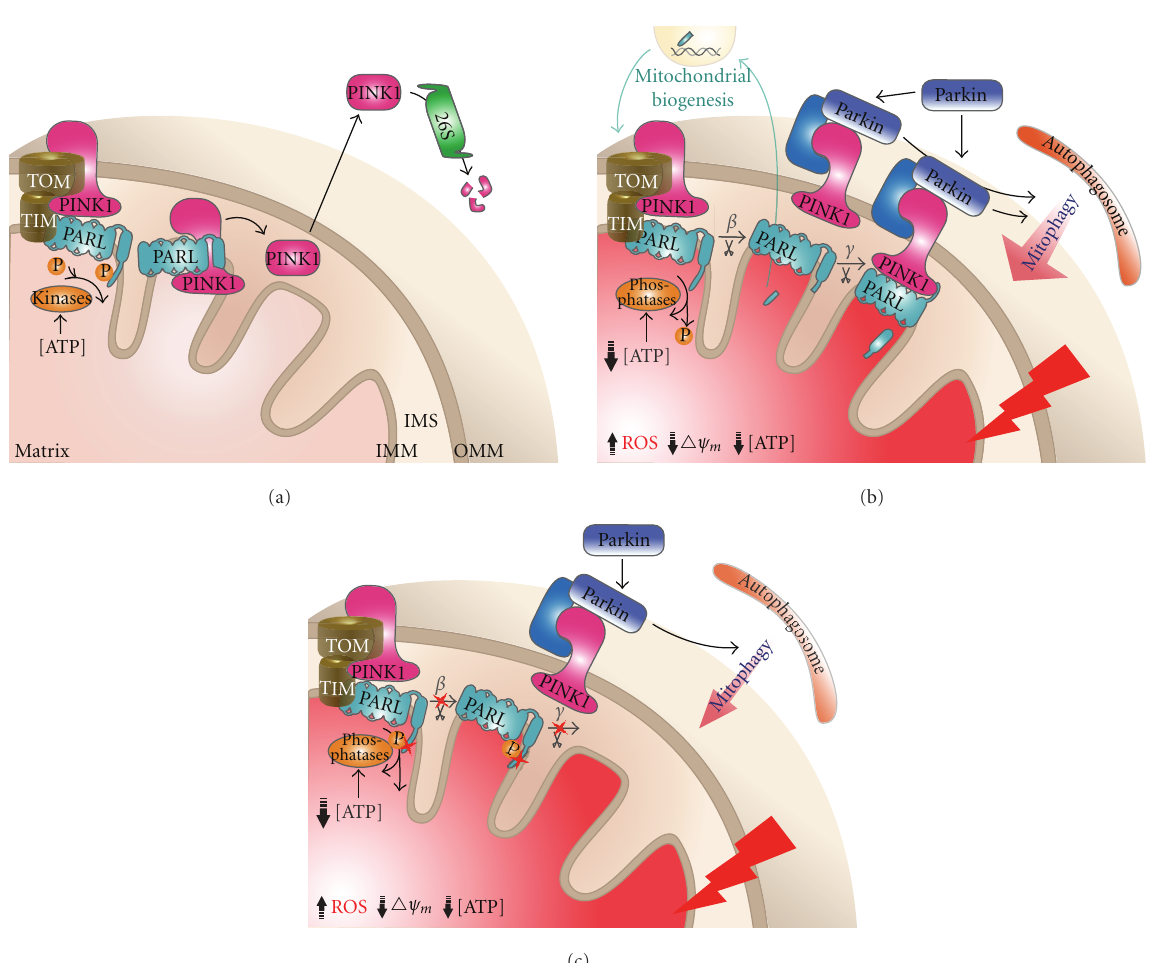
Figure 4: Proposed model for how PARL regulates PINK1 localization under normal conditions and during stress. (a) In a healthy mitochondrion, newly synthesized PINK1 is imported by the TOM/TIM complex. Once it is tethered to the inner mitochondrial membrane (IMM), PINK1 is e ff ectively cleaved by the mitochondrial rhomboid protease PARL, which associates with the TOM/TIM protein-importing machinery. This PARL-dependent cleavage releases PINK1 into the intramembrane space (IMS). The cleaved PINK1 is then retrotranslocated to the cytoplasm, where it undergoes rapid proteasomal degradation. Normal mitochondrial ATP levels facilitate the phosphorylation of the PARL N-terminus. These phosphorylations inhibit the self-regulated proteolysis ( β -cleavage) that releases the PARL N-terminal domain. (b) During stress, such as accumulation of ROS and the depolarization of mitochondrial membrane potential, mitochondrial ATP levels drop significantly as a result of an inhibition of the electron transport chain. Reduced ATP levels result in the dephosphorylation of the PARL N- terminus, which leads to β -cleavage. β -cleavage generates a short nuclear-targeted peptide, p β , which activates the expression of several genes involved in cell metabolism and mitochondrial biogenesis. Another product of β -cleavage, the N-terminal cleaved PARL, then undergoes another cleavage at the loop connecting its first and second transmembrane domains. This cleavage, known as γ -cleavage, separates the first transmembrane domain from the rest of the protein and leaves a catalytically dead PARL. Disruption of membrane potential also inhibits the import of PINK1; instead of being imported to the IMM, PINK1 stalls at the import machinery. Because of its association with the TOM/TIM complex, the catalytically dead PARL stabilizes PINK1 on the OMM to recruit Parkin. Parkin triggers the recruitment of autophagosomes, which eliminates the damaged mitochondria through a process called mitophagy. Through other mechanisms, PINK1 may be anchored on the OMM but with a lower e ffi ciency. (c) When β -cleavage is inhibited, PARL retains its uncleaved form even when the mitochondrial ATP levels are low. Therefore, during stress, PARL with impaired β -cleavage can no longer facilitate the OMM-anchoring of PINK1. Although PINK1 may be anchored to the OMM by other mechanisms, due to their low anchoring e ffi ciency, there will be less OMM anchored PINK1. As a result, Parkin recruitment to damaged mitochondria as well as subsequent mitophagy will be impaired. As a mitochondrial quality control system, failure of proper mitophagy would lead to an accumulation of damaged mitochondria and eventually trigger the cell death pathway, which is one of the contributors to neurodegeneration in